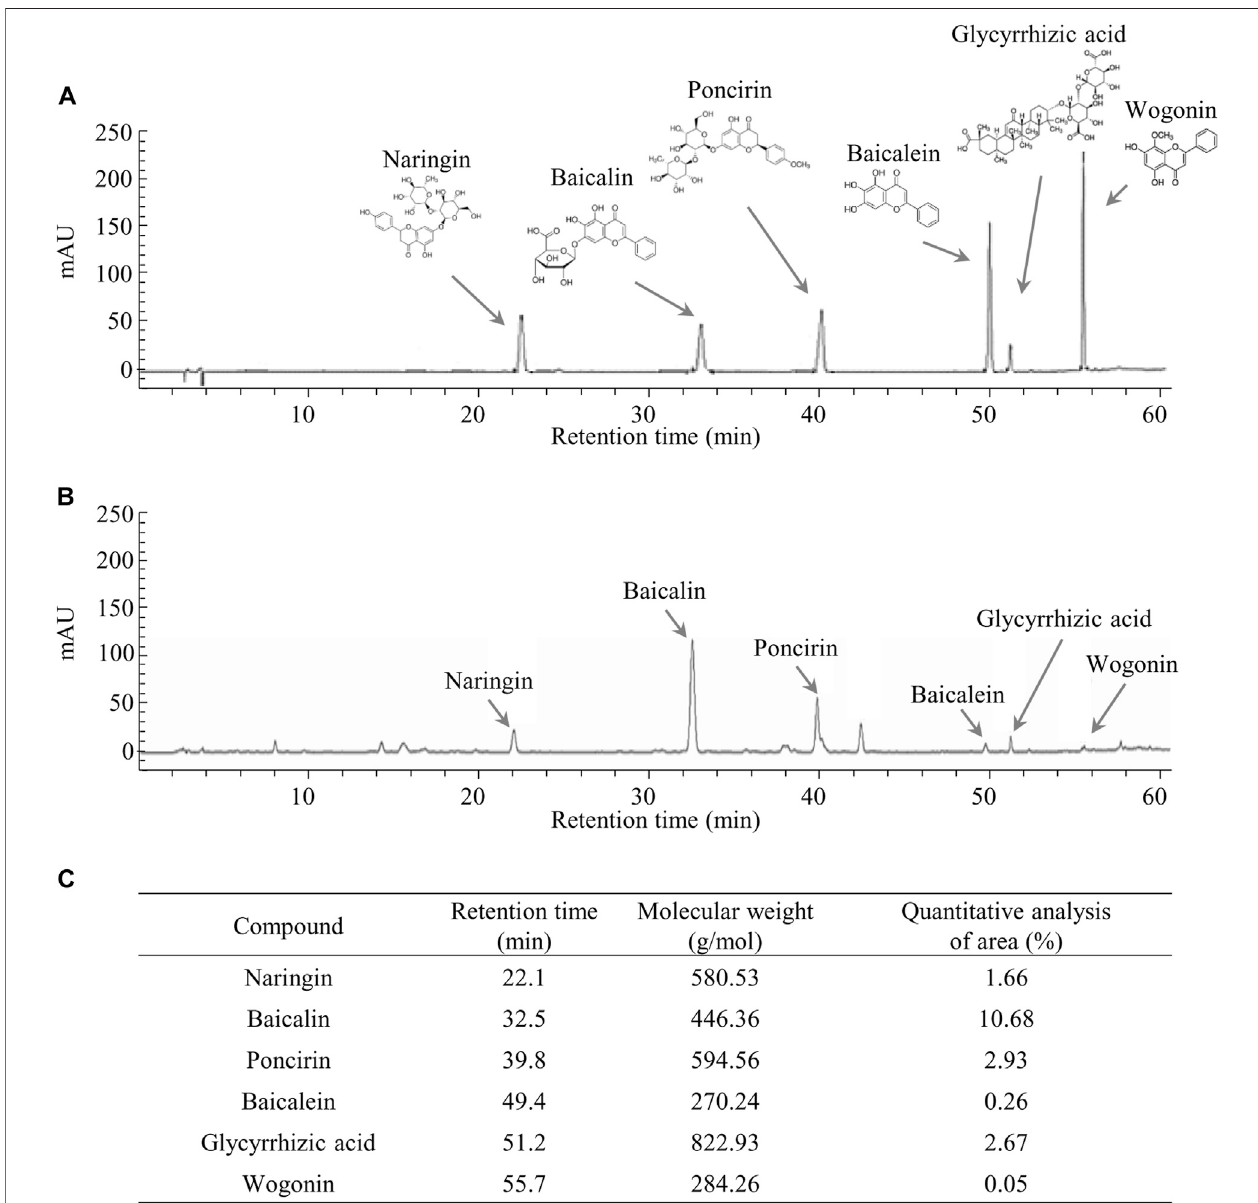
FIGURE 1 | Fingerprinting analysis of Yeokwisan . Chemical constitutions and quantitative analysis of Yeokwisan using high-performance liquid chromatography (HPLC). Six reference standards (A) and Yeokwisan (B) were subjected to UHPLC analysis. Quantitative analysis of Yeokwisan was conducted (C) .